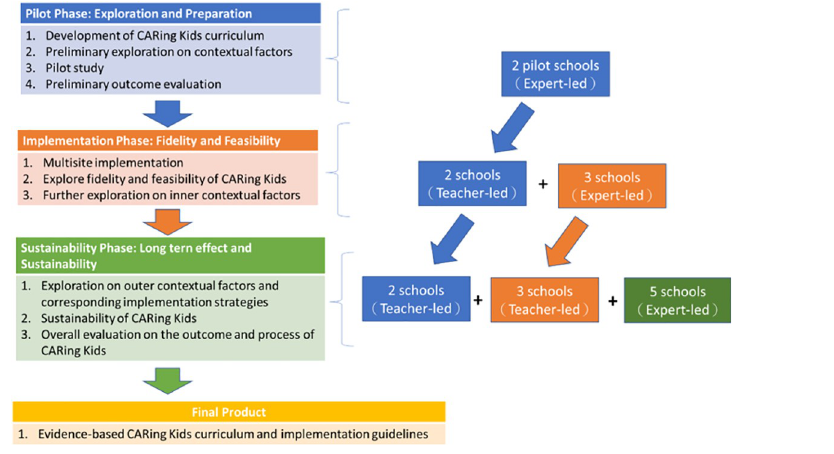
Fig 1. Phases of the CARing Kids